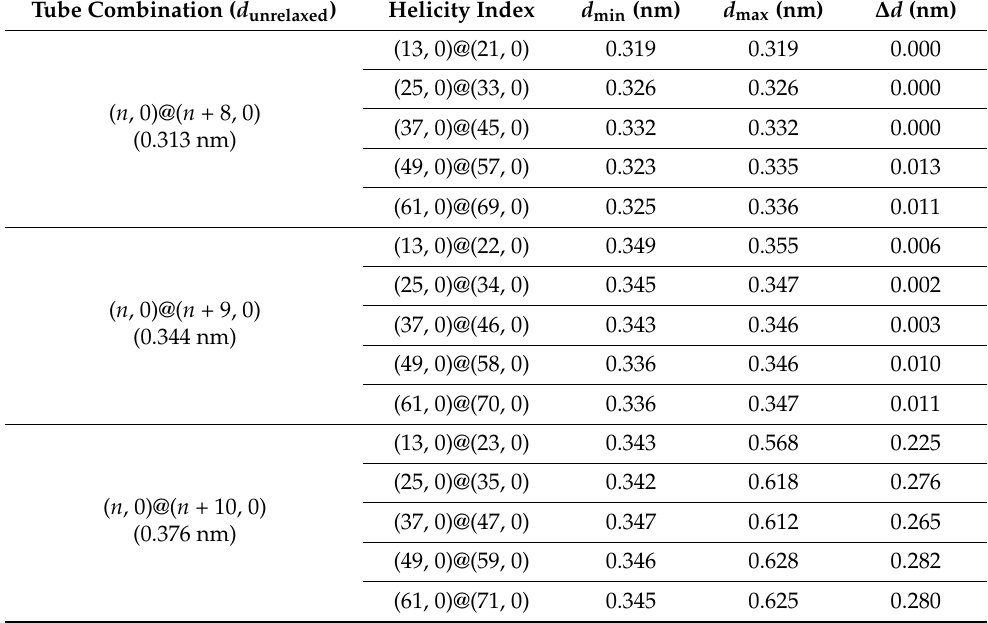
Table 1. DFT-D2 optimised geometry parameters of ( n , 0)@( n + x , 0) zigzag DWCNT combinations, where x = 8, 9, and 10. The intershell spacing d of the unrelaxed case when both shells had the same central axis are indicated in brackets beneath the DWCNT description. The minimum ( d min ) and maximum ( d max ) intershell distance and the difference between them ( Δ d ) are given in nm. Only some of the points reported in Figure 10 are listed here as representative points. The whole data set is provided in Supplementary Materials.